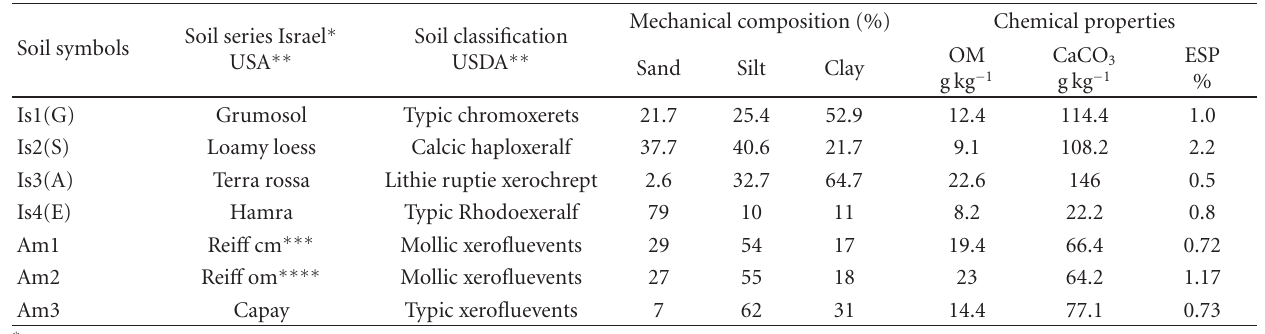
Table 1: Selected characteristics of the soil samples.